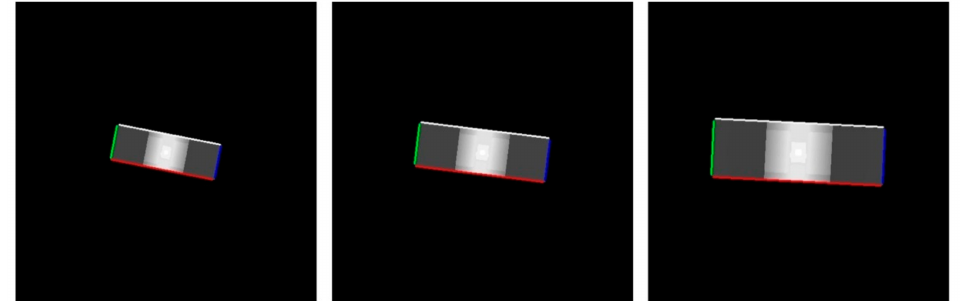
Figure 4. The example of the line matching result in depth map (from left to right: partial results of the sensor sequence